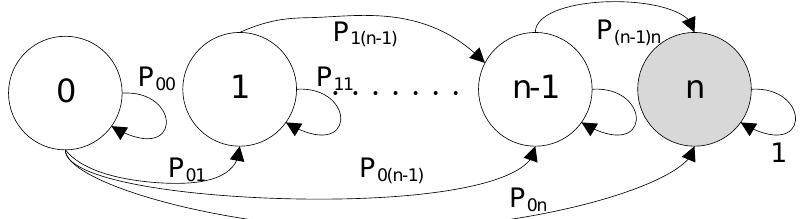
Figure 3. Generalized state transition diagram of the absorbing Markov chain that models the evolution of the numbers of end-devices that succeed in transmitting data using FSA-ACK, FSA-FBP and DFSA (Dynamic